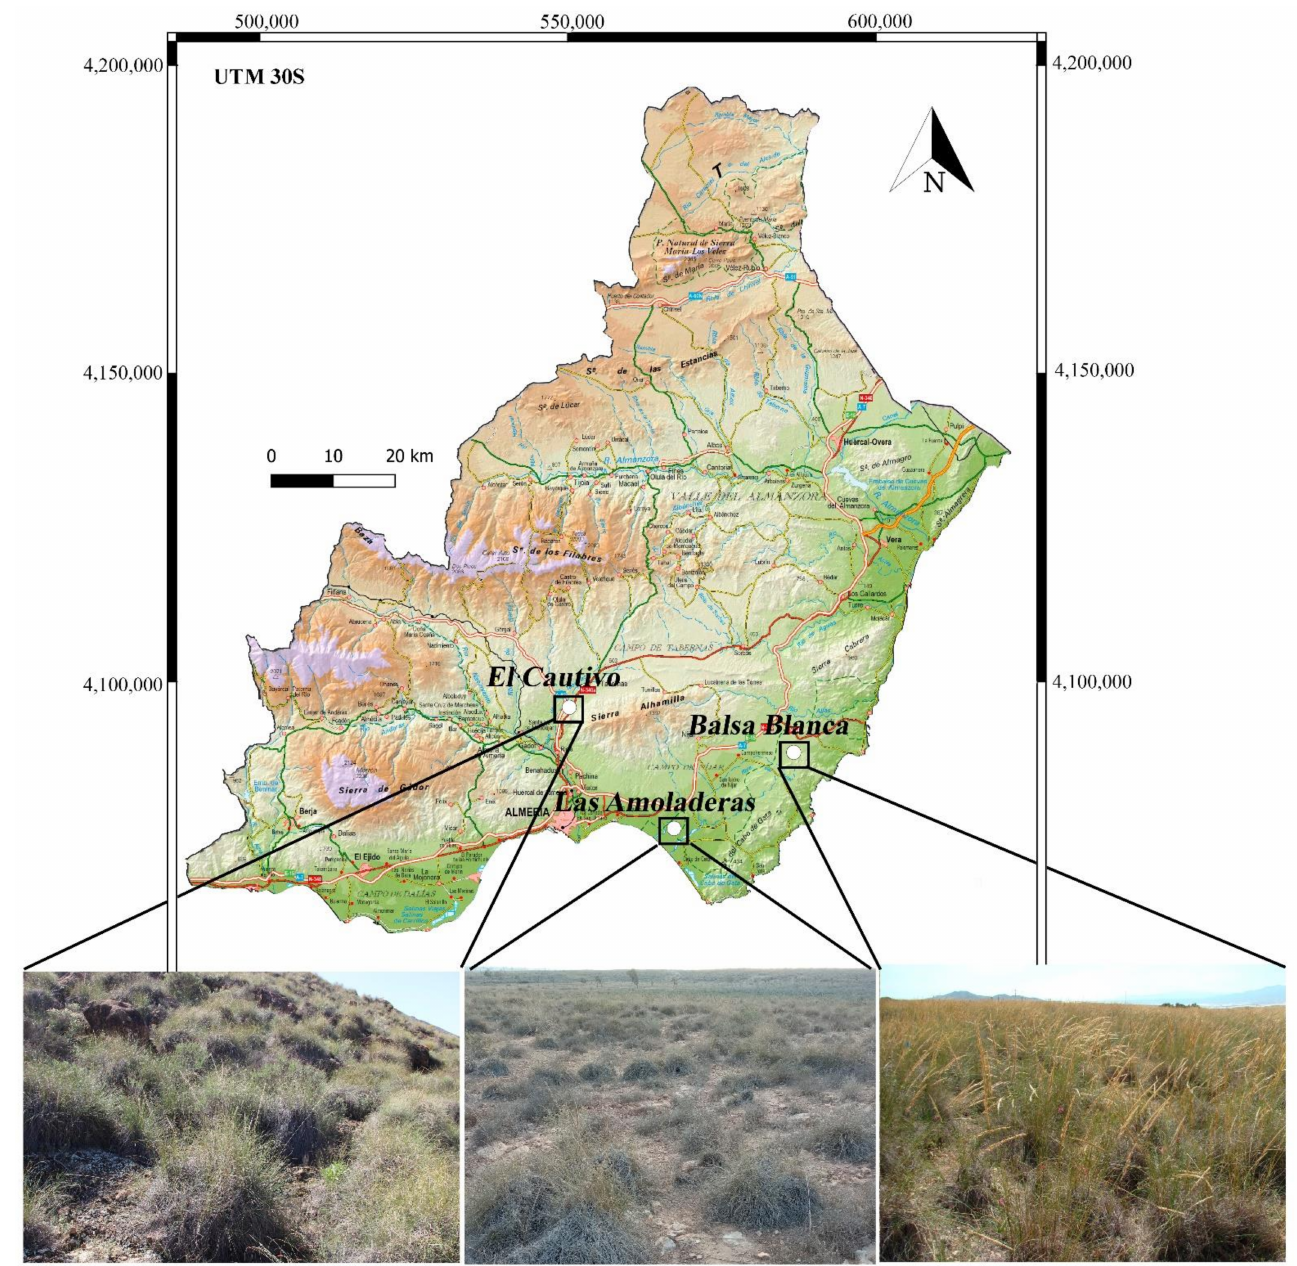
Figure 1. Location and detailed images of the three Macrochloa tenacissima L. dominated ecosystems selected for this study: El Cautivo, Las Amoladeras, and Balsa